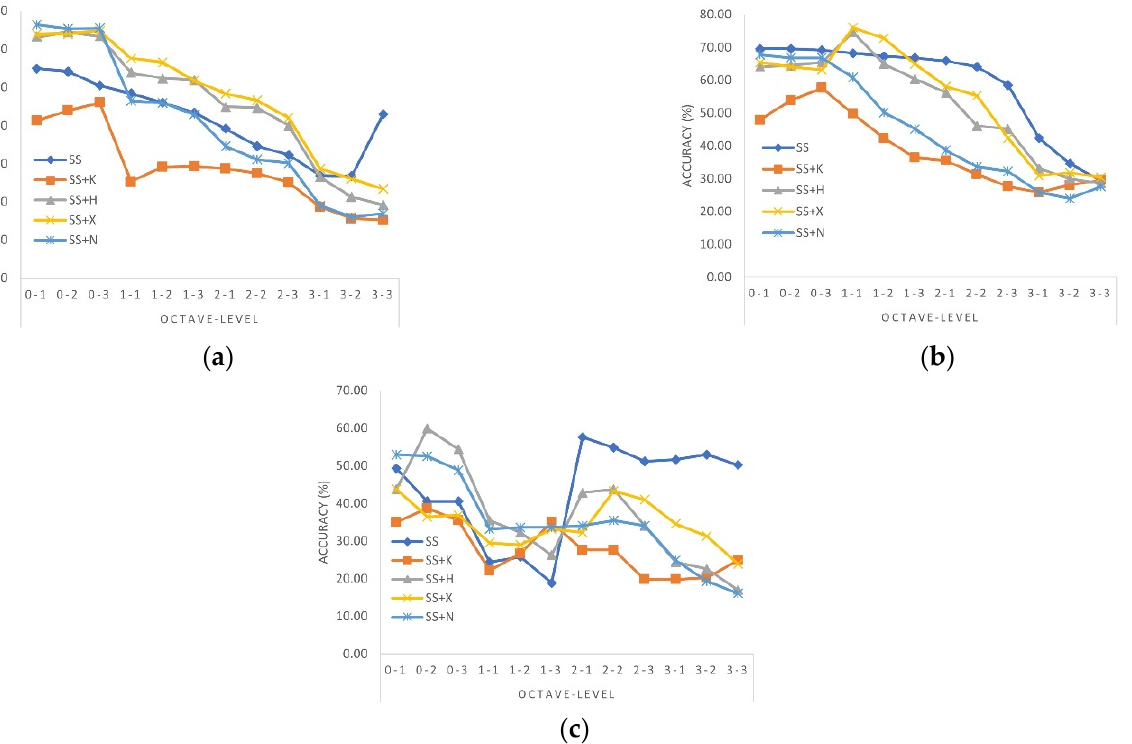
Figure 3. The accuracy results (%) from ( a ) 1 -NN , ( b ) SVM -1, and ( c ) SVM -2. The results were evaluated for 12 octave O and level L variables from SS and 5 curvature-based scale spaces ( SS , SS + K , SS + H , SS + X , and SS + N ).